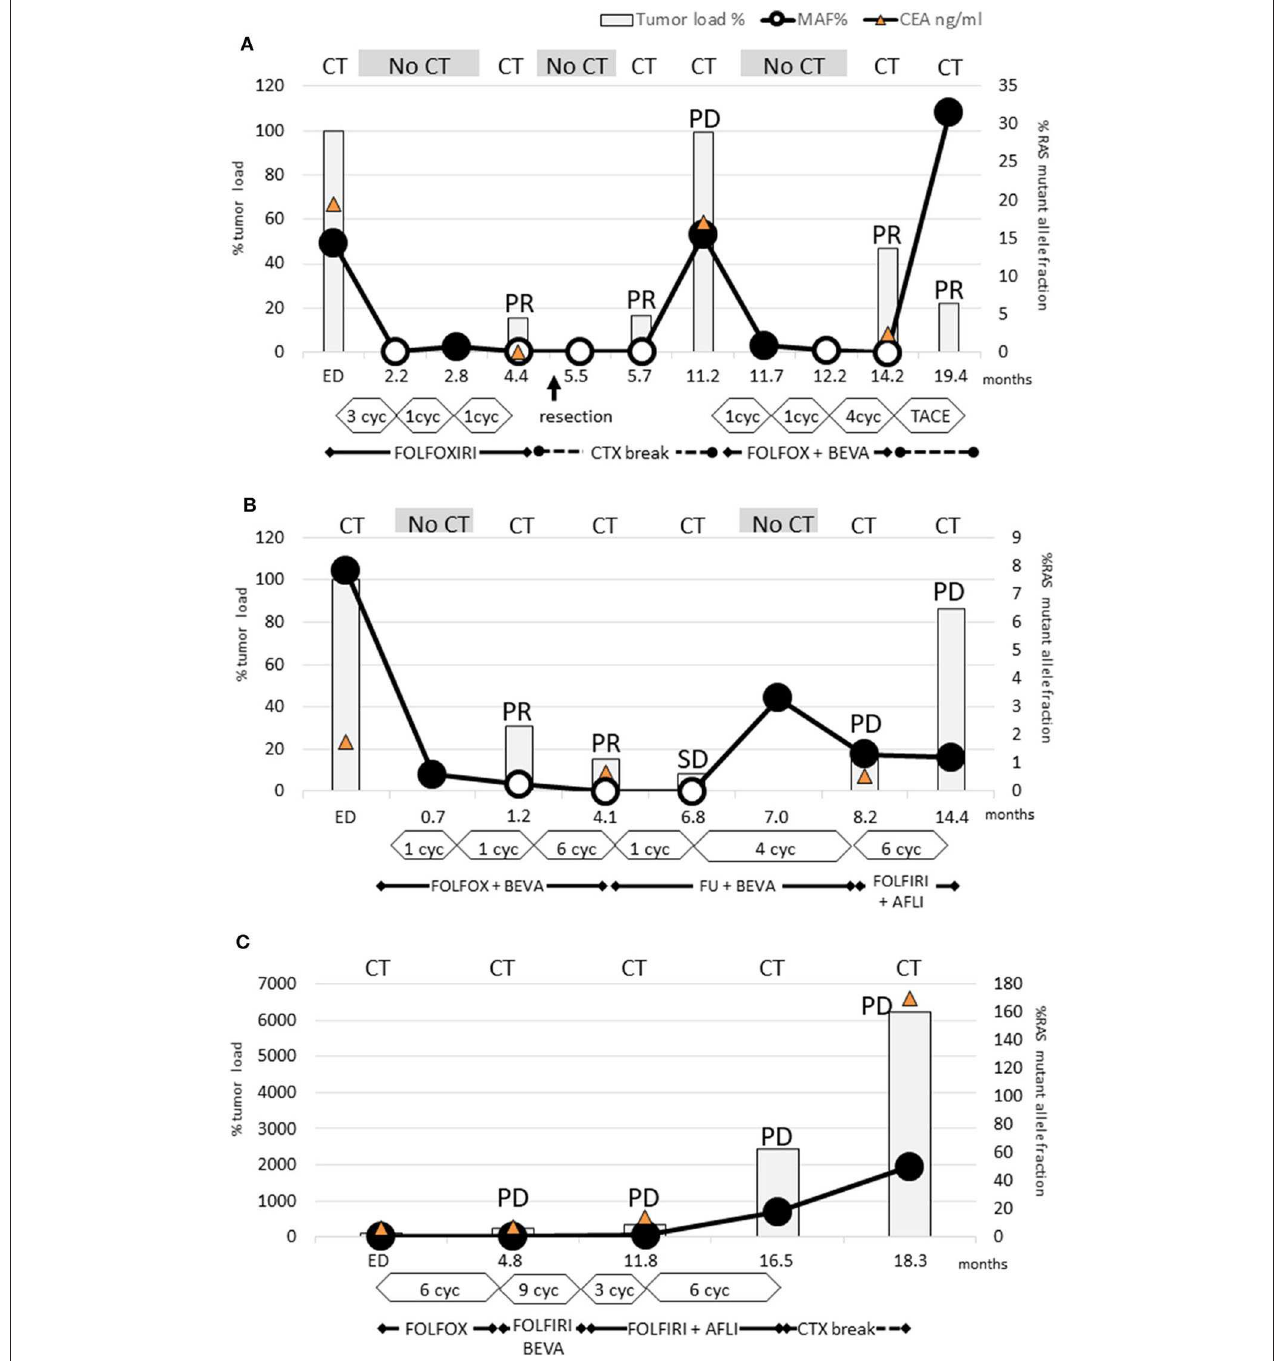
FIGURE 1 | Dynamics of KRAS mutant clones measured in plasma samples. (A) Patient 3: RAS mutations disappeared already after 3 cycles FOLFOXIRI and remained not detectable for 9 months. PR after 6 cycles FOLFOXIRI made the patient eligible for tumor resection (arrow). After the following chemotherapy break PD occurred simultaneously with renewed rise of RAS mutation load. Already after 1 cycle FOLFIRI and bevacizumab the RAS mutations disappeared again and rose only after the next chemotherapy break due to TACE treatment. This case conclusively demonstrated that even multiple conversions of RAS status are possible with appropriate chemotherapy. (B) Patient 4: Already after 2 cycles FOLFIRI + bevacizumab the RAS mutations disappeared and remained not detectable for 6 months. Due to PR after 8 further cycles, the treatment was deescalated to 5-FU and bevacizumab. During this period, RAS mutation load increased again. Next, PD was diagnosed and the subsequent treatment change to FOLFIRI and aflibercept failed to achieve tumor response. However, RAS mutation load did not increase. This case points out that a renewed rise of RAS mutation load may be an early indicator for a lack of response. Furthermore, it can decrease during PD indicating that PD is caused by a RAS wild-type clone. (C) Patient 12: Neither FOLFOX nor FOLFIRI or addition of anti-VEGF antibody therapy led to a decrease of RAS mutation load or tumor response.